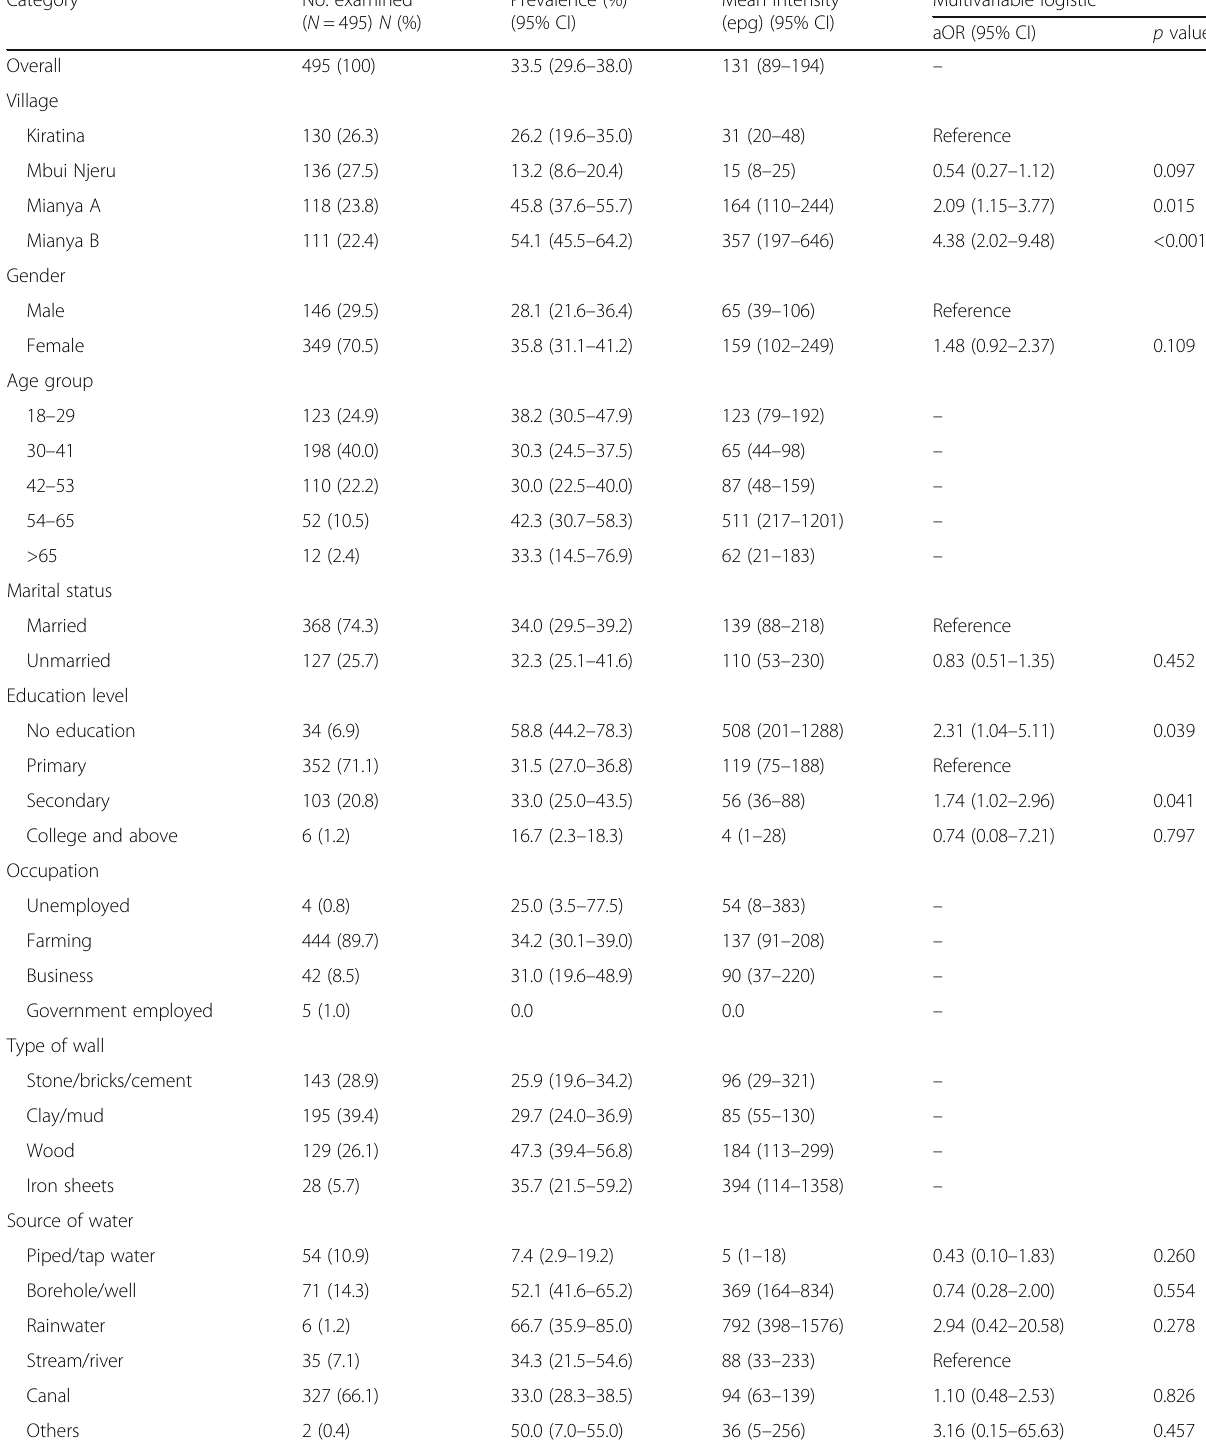
Table 1 Prevalence (%), mean intensity (epg) and risk factors associated with S. mansoni